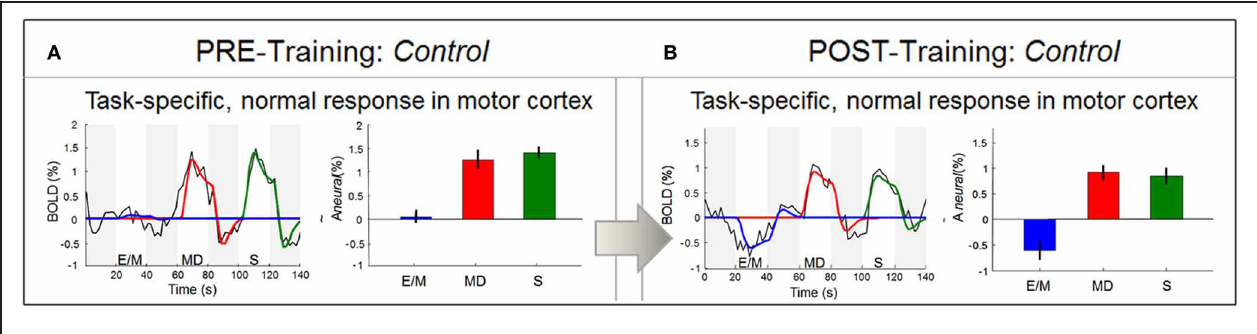
FIGURE 9 | Response waveform analysis in motor cortex. In contrast to area V1, the LH motor cortex M1 (in particular, the region encoding right-hand movement) produced well-formed response waveforms both before training (in A ) and after training (in B ). As should